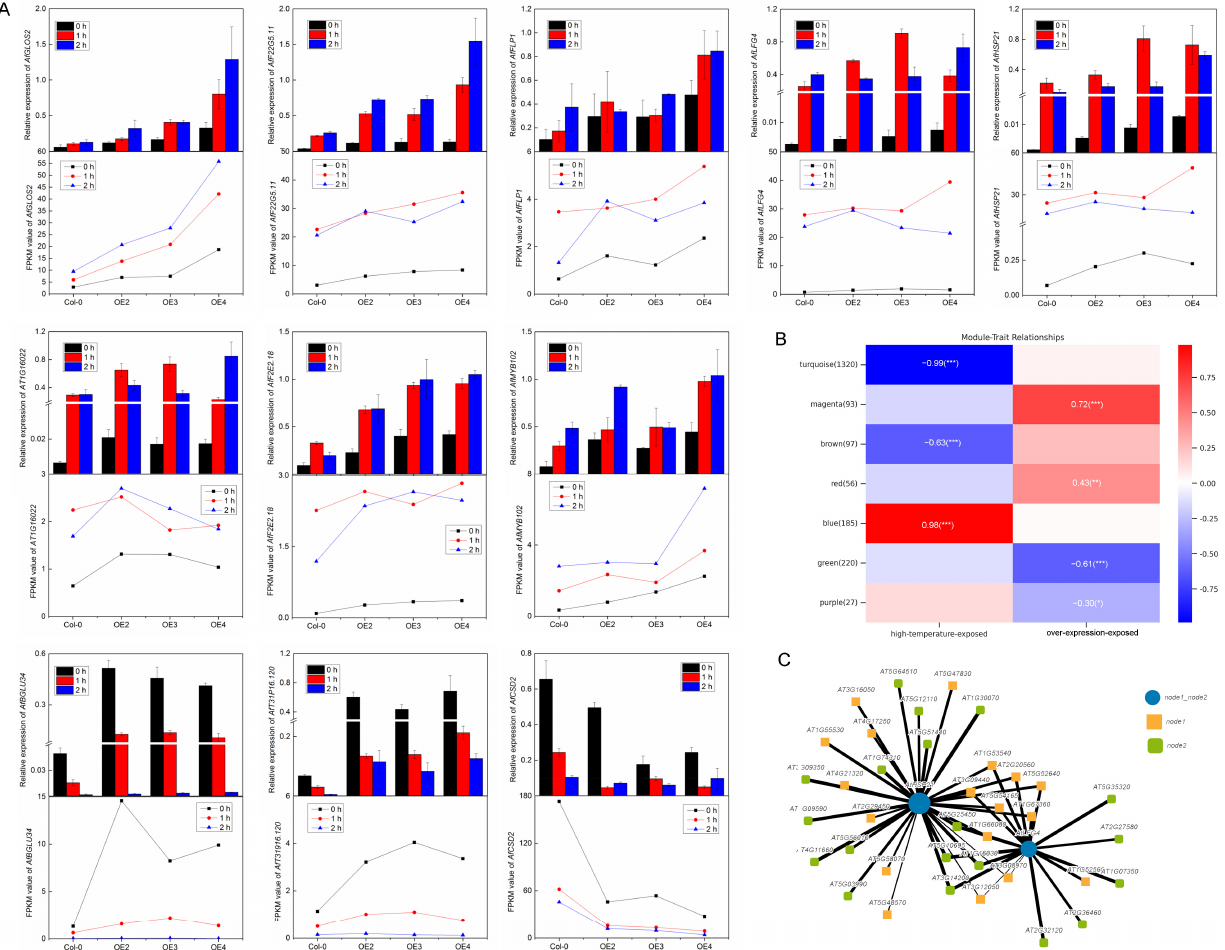
Figure 7. DEG analysis. ( A ): Relative expression (qRT-PCR) and FPKM value of 11 genes in different lines (Col-0, OE2, OE3, OE4) under heat stress; ( B ): Heat map of character module correlation; ( C ): Hub network of AtHSP21 and AtLFG4. The *, **, and *** indicates a significant difference ( p < 0.05, p < 0.01, and p < 0.001, respectively).